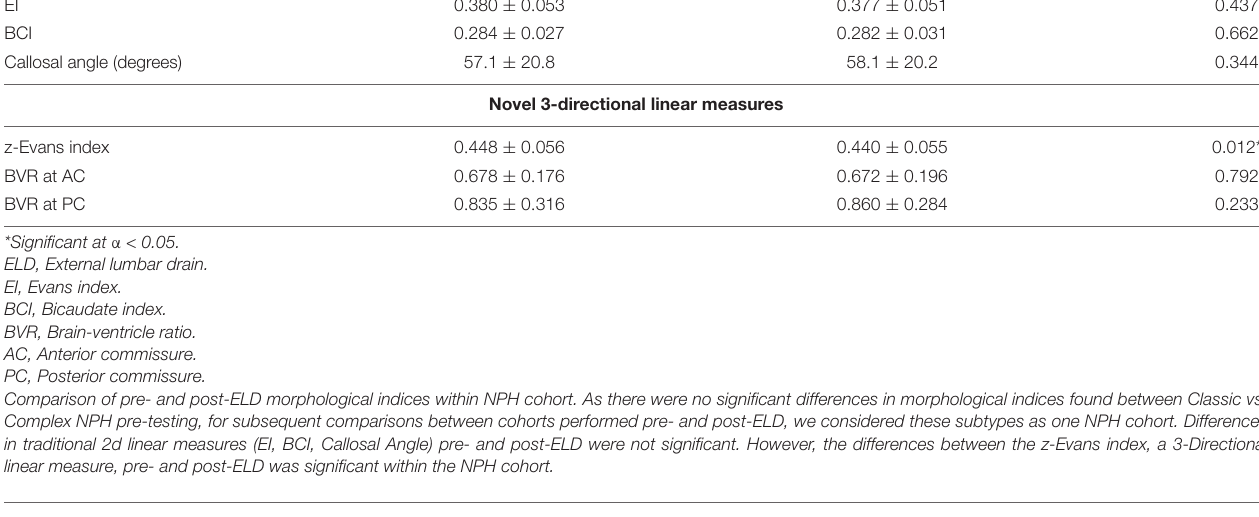
TABLE 6 | Classification of normal pressure hydrocephalus (NPH) cohorts by timepoints pre- vs. post-lumbar testing: morphological indices within groups compared by their responsiveness to external lumbar drainage (ELD).